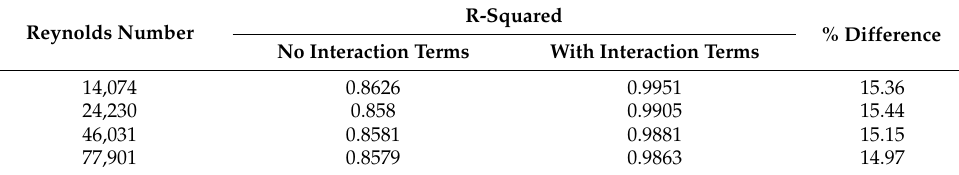
Table 6. Comparison of the regression analysis (with and without interaction terms).